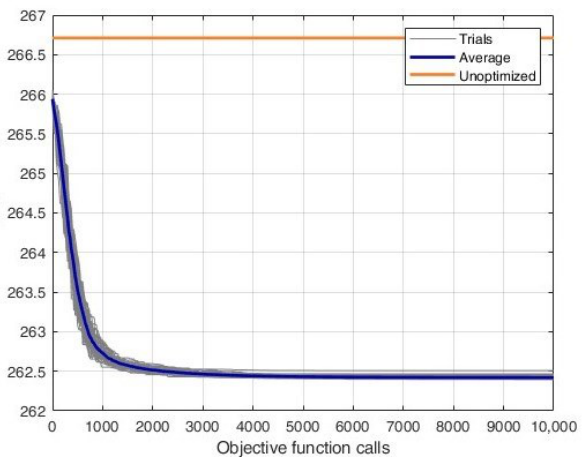
Figure 8. Convergence curves for the basic optimisation. Each grey line represents one of the 50 independent trials; the blue line is the average convergence; and the orange line is the cost value of the unoptimised